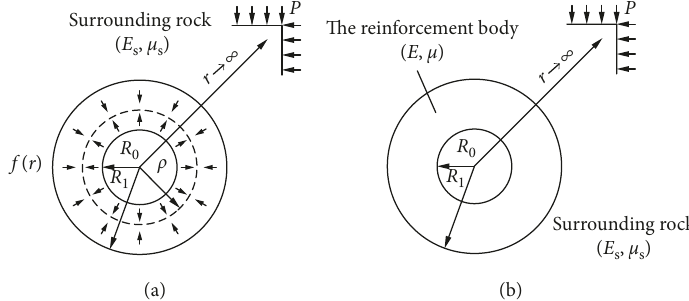
Figure 3: Elastic analysis of the surrounding rock deformation under (a) anchor support and (b) the surrounding rock reinforcement body support.